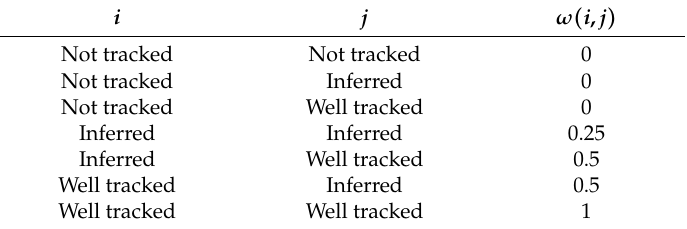
Table 2. The weight coefficient for error recognition